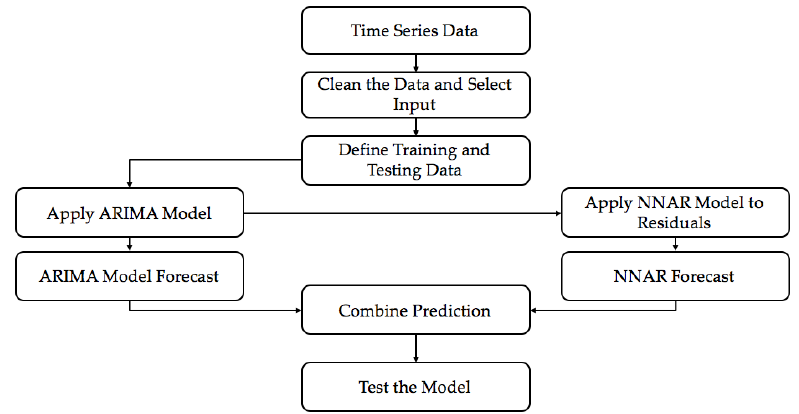
Figure 8. Flowchart for the Hybrid Model.